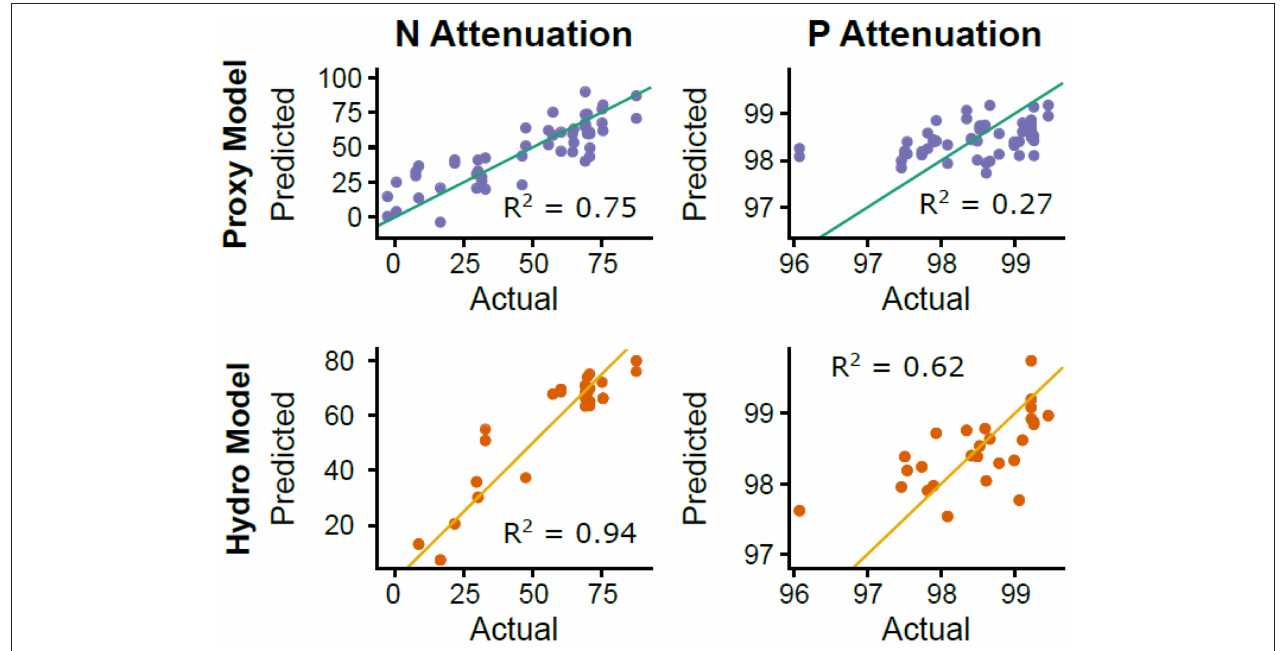
FIGURE 9 | N and P attenuation (based on mass balance estimates reported as percentages) predicted by hydrological and watershed characteristics, and biogeochemical proxies. The “hydro” model included hydrological and watershed characteristics and the “proxy” model included biogeochemical proxy data from the three field campaigns (see Table 2